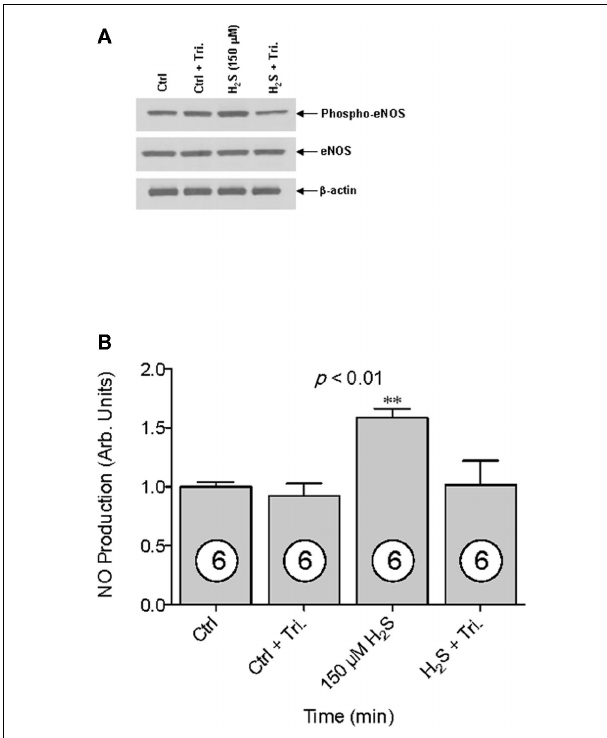
FIGURE 3 |The effect ofAkt inhibition on H 2 S-stimulated NO production. (A) Western blot analysis demonstrating total, ser1177-eNOS (phospho-eNOS), and actin in the presence and absence of the AKT inhibitorTriciribine (5 μ M). (B) NO production was measured using EPR spectroscopy. NO values ( y -axis) are presented in arbitrary units and have been normalized to control. NO was measured from untreated (Ctrl), Triciribine treated (Ctrl + Tri.), 150 μ M Na 2 S treated (150 μ M H 2 S), and 150 μ M Na 2 S treated withTriciribine (H 2 S + Tri). Statistical analysis was performed using a one-way ANOVA (ANOVA p -value is in center of figure) with Dunnett’s post hoc test. Numbers inside circles denote the N for each column. An asterisk denotes values significantly different from control by post hoc test, ** p <